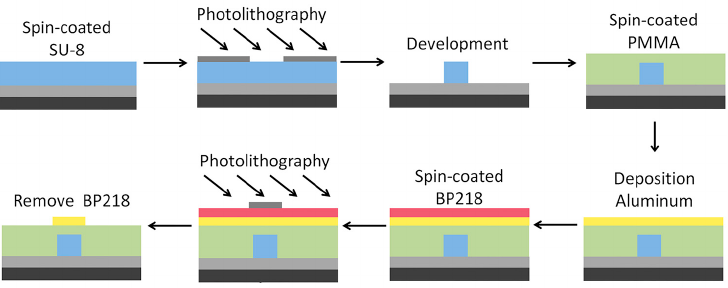
Figure 3. Process flow for fabricating the thermal optical switch.